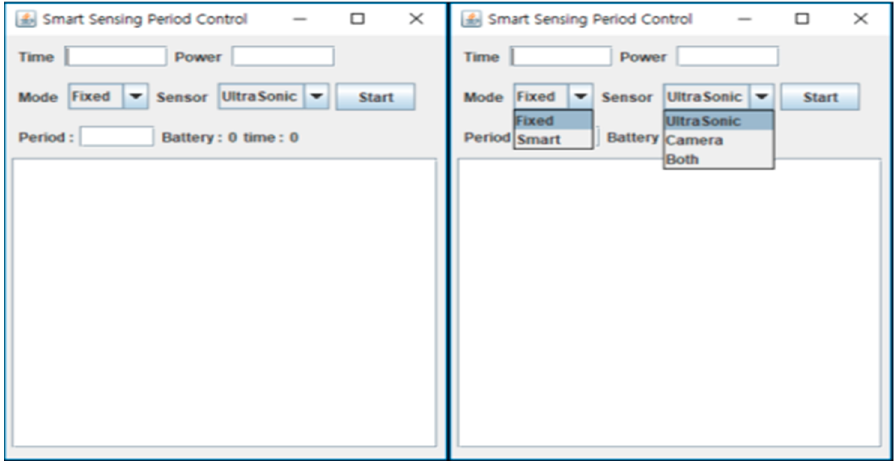
Figure 7. Smart sensing period control user interface.